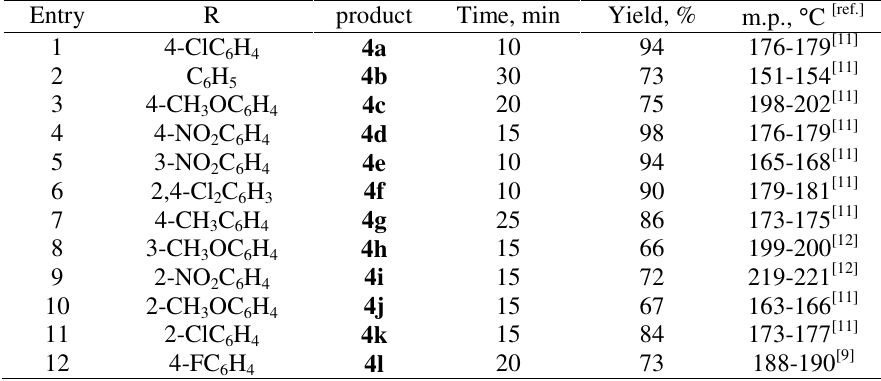
Table 1. Synthesis of